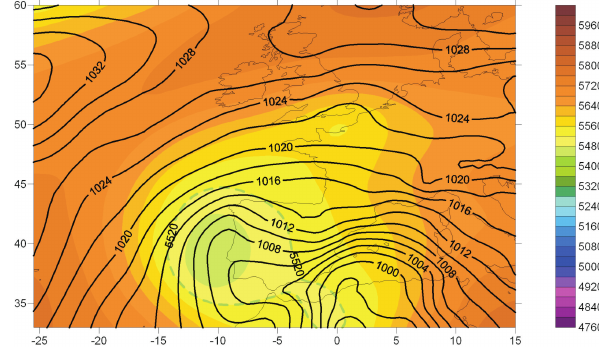
Fig. 11. SLP (lines) and Z500 (colours) during an EA situation. 07/05/2002 at 12:00UTC from ERA-Interim reanalysis done by Eu- ropean Centre for Medium Weather Forecast